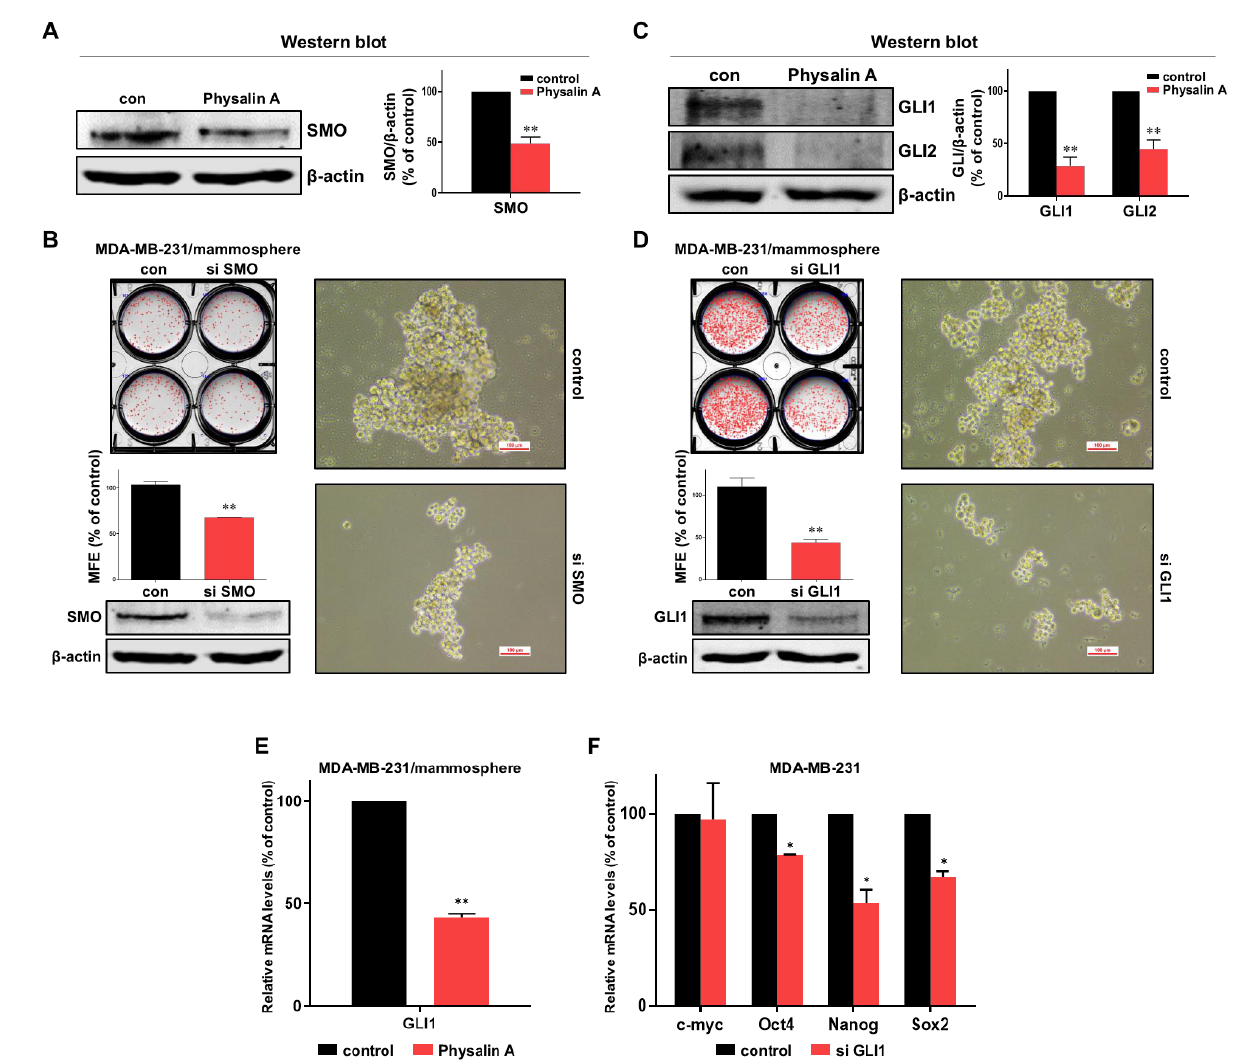
Figure 4. Effect of physalin A on Hedgehog signaling pathway. ( A ) Physalin A decreased the total protein level of SMO in breast mammospheres. An Anti-SMO antibody was used for immunoblotting. ( B ) Effect of SMO on mammosphere formation using SMO small interfering RNA (siRNA). siRNA-transfected cancer cells were incubated for 5 days with a complete Mammocults medium, and mammosphere formation efficiency (MFE) was calculated. ( C ) The protein levels of GLI1 and GLI2 in physalin A-treated mammospheres were assessed using specific anti-GLI1 and anti-GLI2 antibodies. ( D ) The effect of GLI1 protein on mammosphere formation was assessed using siRNA of GLI1. GLI1 siRNA-transfected cells were cultured for 7 days in a complete MammoCult medium and the MFE was determined. ( E ) Physalin A treatment reduced Hedgehog signaling-related GLI1 gene expression in the mammospheres derived from MDA-MB-231 cells. ( F ) After transfection of GLI1 siRNA, total RNA was extracted from breast cancer cells. The transcripts levels of c-myc, Oct4, Nanog, and Sox2 were measured by RT-qPCR using specific primers. β -actin was used as the internal control. Mean ± SD values from three independent experiments are presented. * p < 0.05, ** p < 0.01 vs. control.